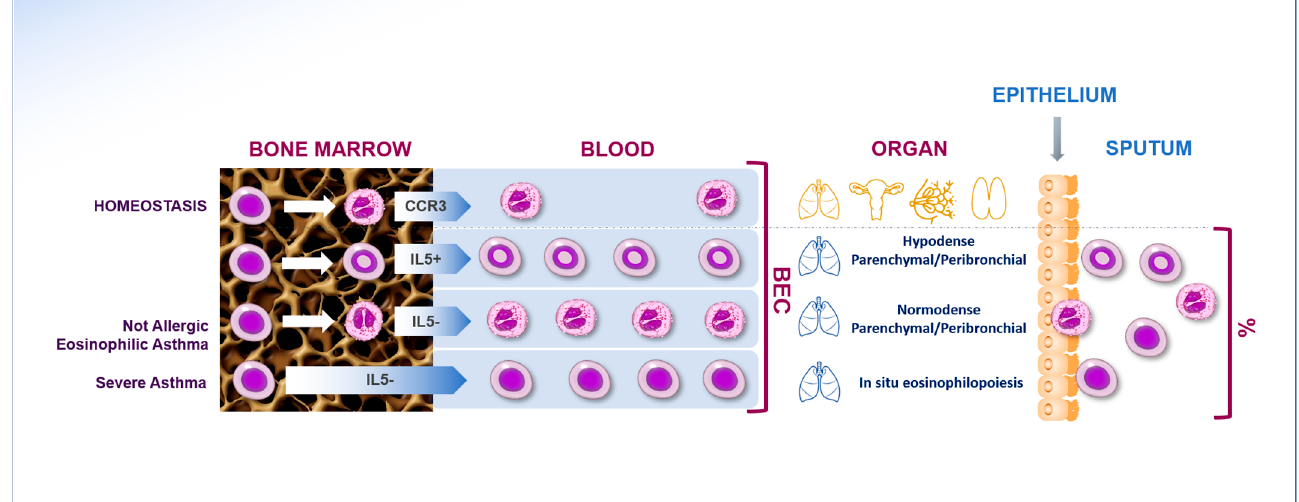
Figure 1. Eosinophil endotypes derived from different signals perceived by the developing progenitors of eosinophils. There may be a different expression of eosinophil subpopulation differing from their localization (parenchymal/peribronchial and in situ), cellular density profiles (hypodense/normodense), asthma endotypes (allergic/non-allergic eosinophilic), and responsiveness to IL-5.